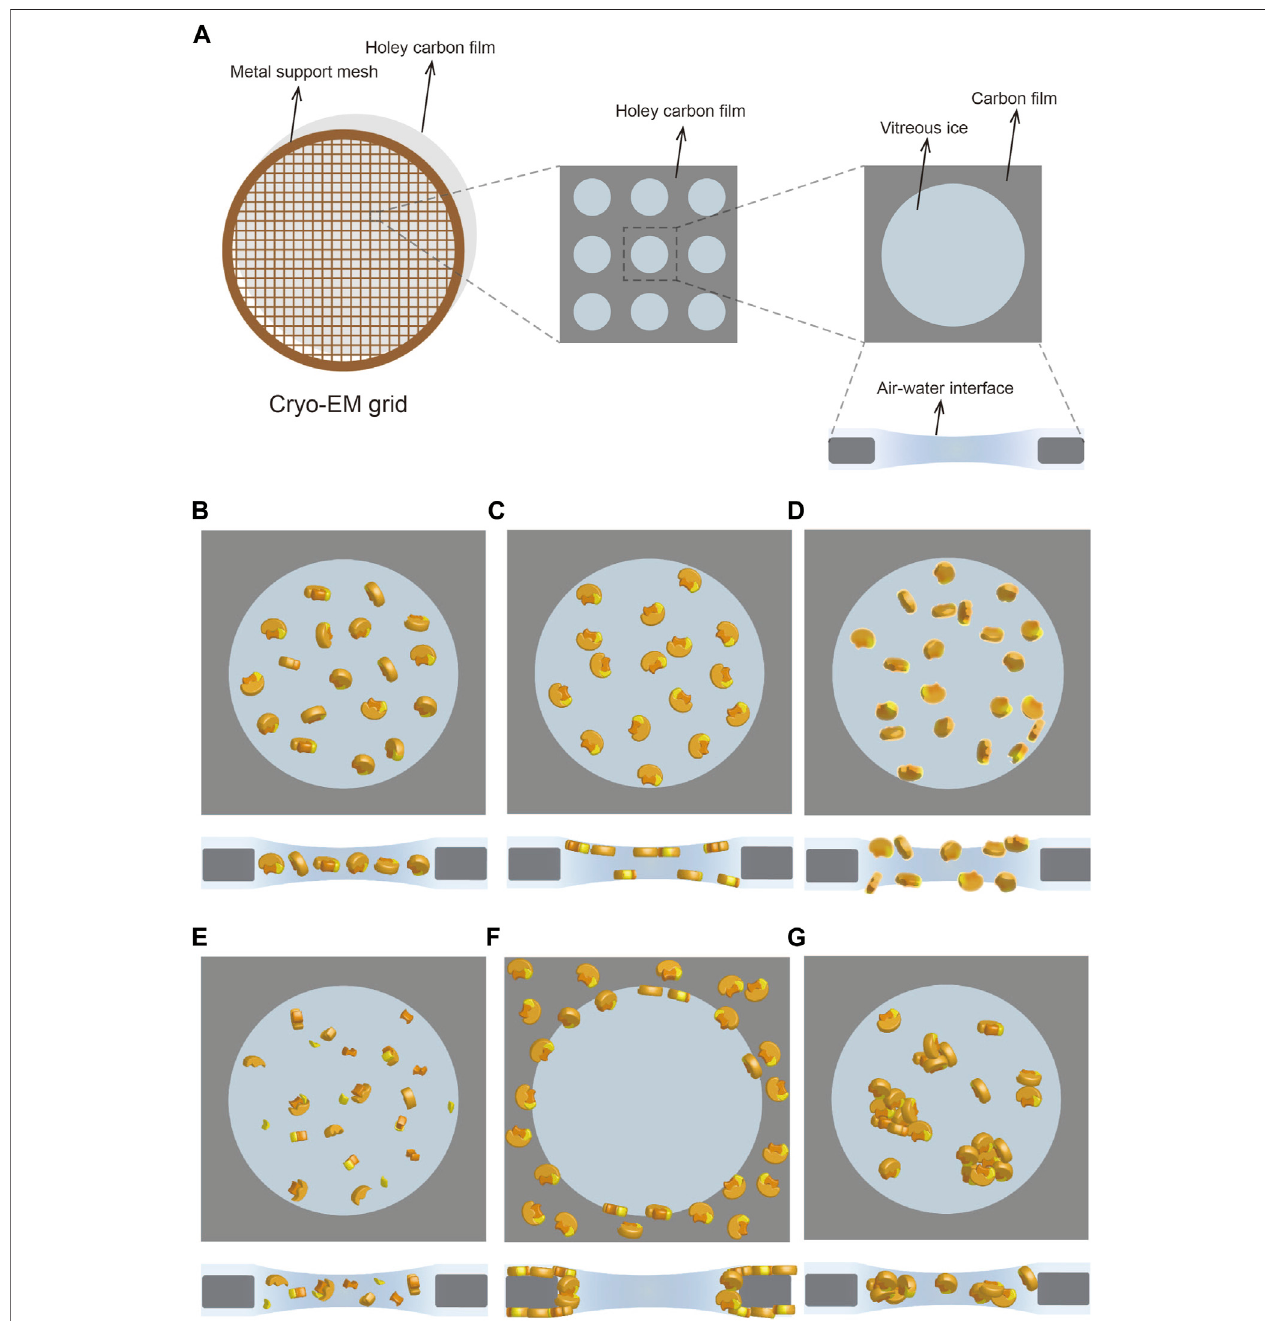
FIGURE1| Cryo-specimeninsingle-particlecryo-EM. (A) Cryo-EMgridusuallyhasametalsupportmeshandaholeycarbon fi lmtocarrythesamplesolution.The particlesarefrozeninvitreousiceintheholesforimageacquisition (B – G) Differentstatesofparticlesinvitreousice,includingidealsituation (B) ,preferredorientation (C) , denaturation (D) , disassembly (E) , adsorption on carbon fi lm (F) , and aggregation (G) . Subunits in the protein complex are shown in yellow, orange, and lemon, respectively.